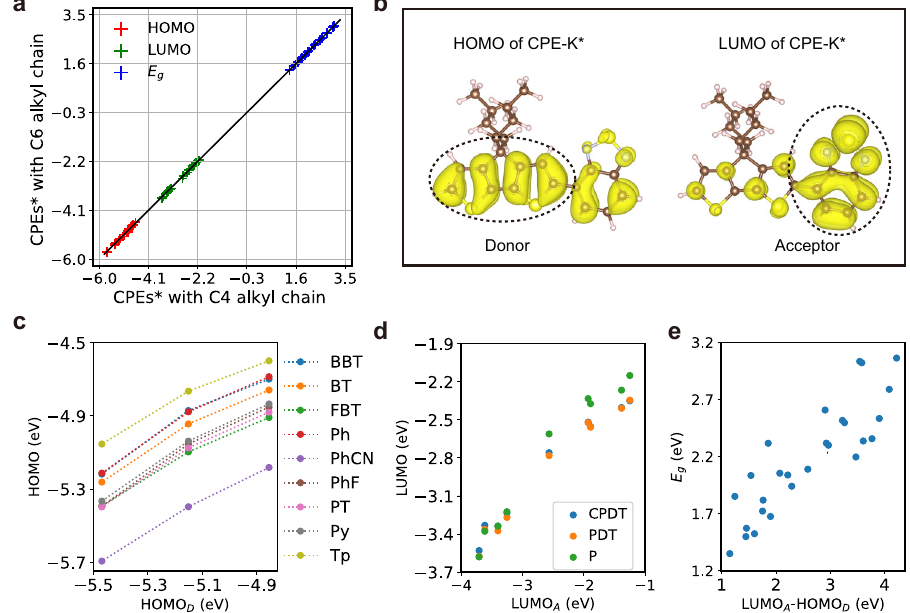
Fig. 3 Dependence of HOMO, LUMO and E g on structural components. a Comparisons for HOMO/LUMO levels and E g between CPEs* with C4 and C6 alkyl chains. b Charge density of HOMO and LUMO orbitals in CPE-K*. c HOMO level of CPE* as a function of HOMO level of the donor (HOMO D ). d LUMO level of CPE* as a function of LUMO level of the acceptor (LUMO A ). e E g of CPE* as a function of LUMO A – HOMO D